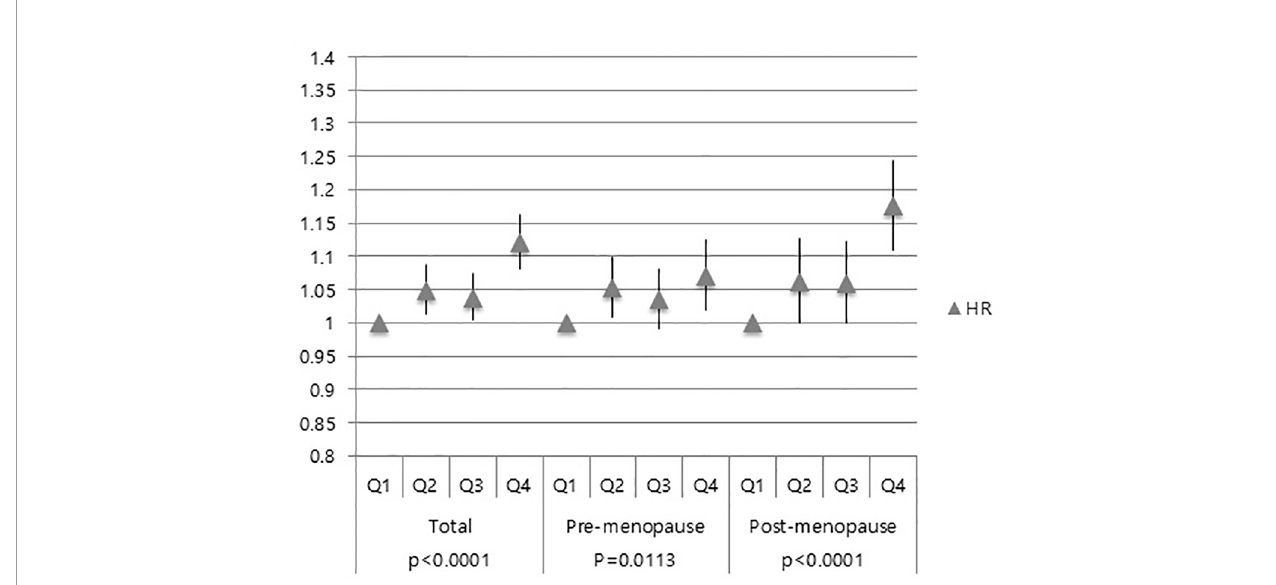
FIGURE 2 | Association of GGT levels with breast cancer risk in total subjects, pre-menopausal women and post-menopausal